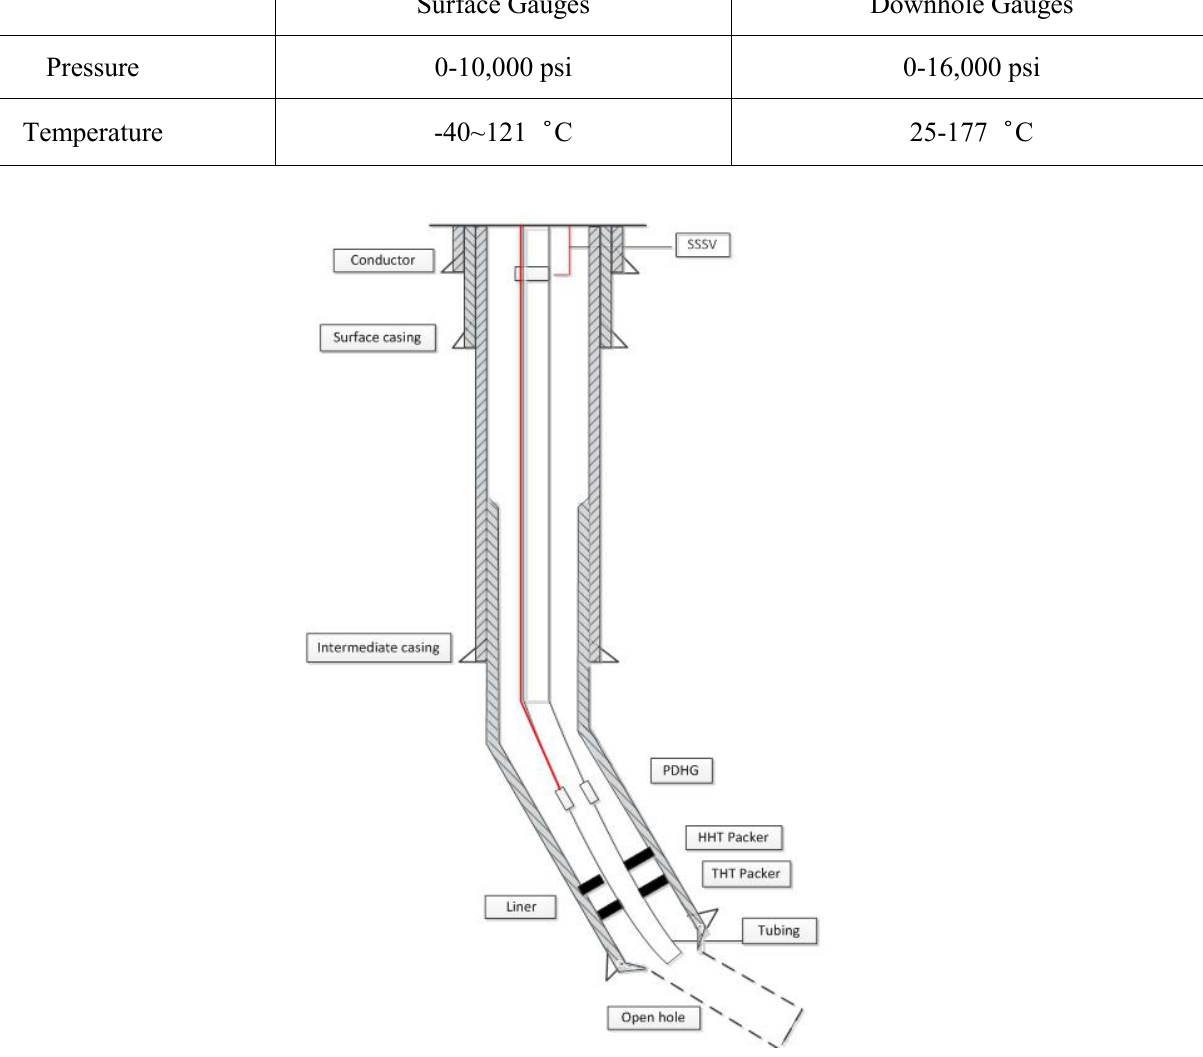
Figure 4—Schematic of new wellbore